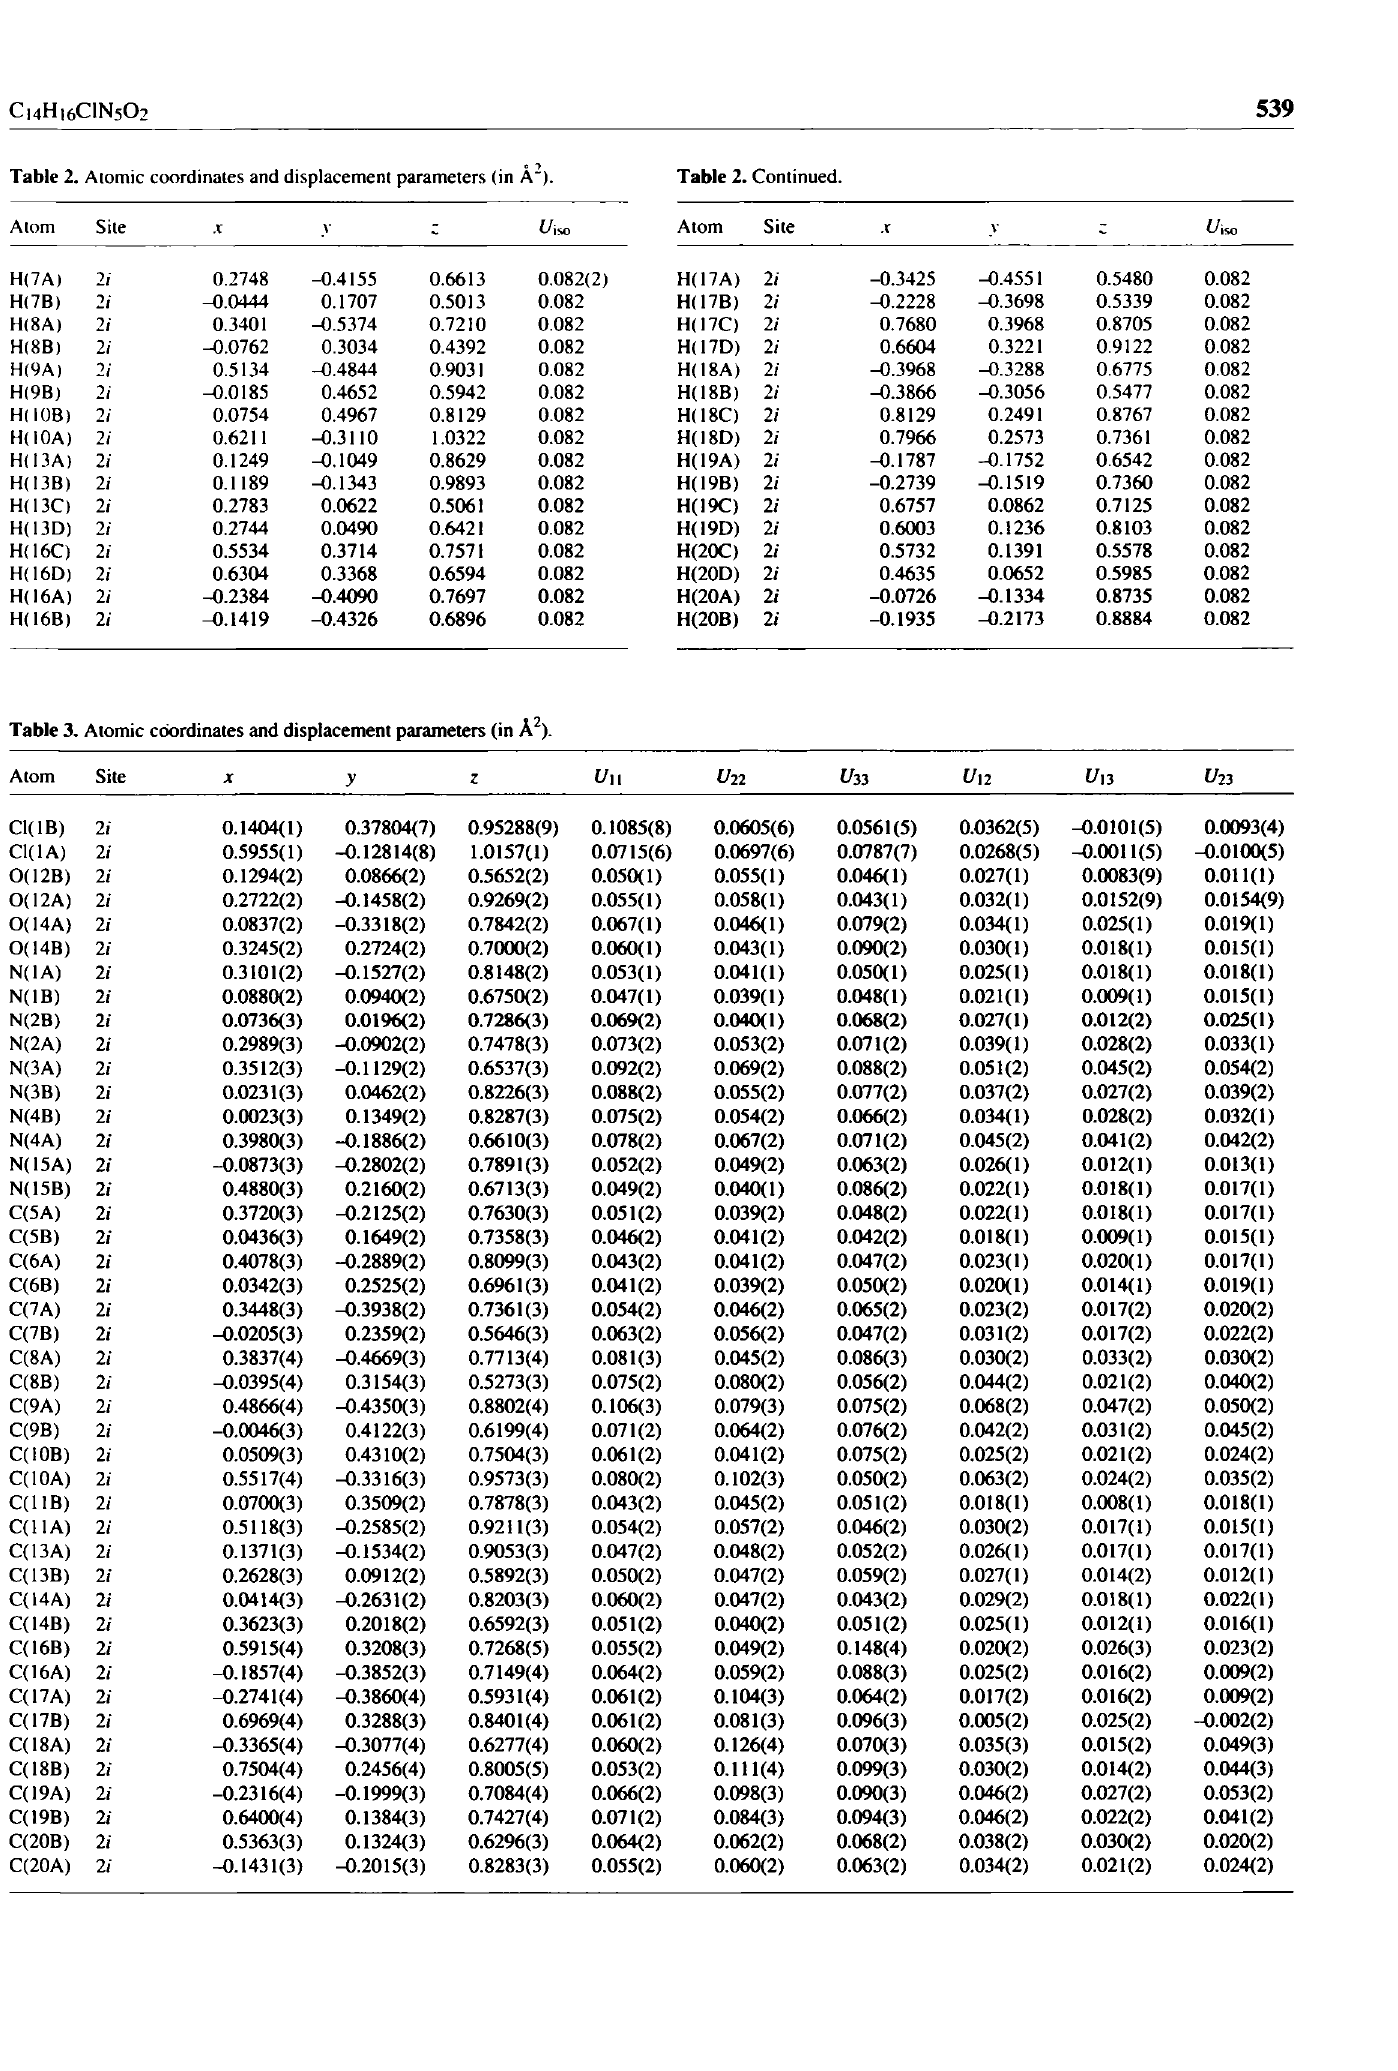
Table 3. Atomic cdordinates and displacement parameters (in A 2